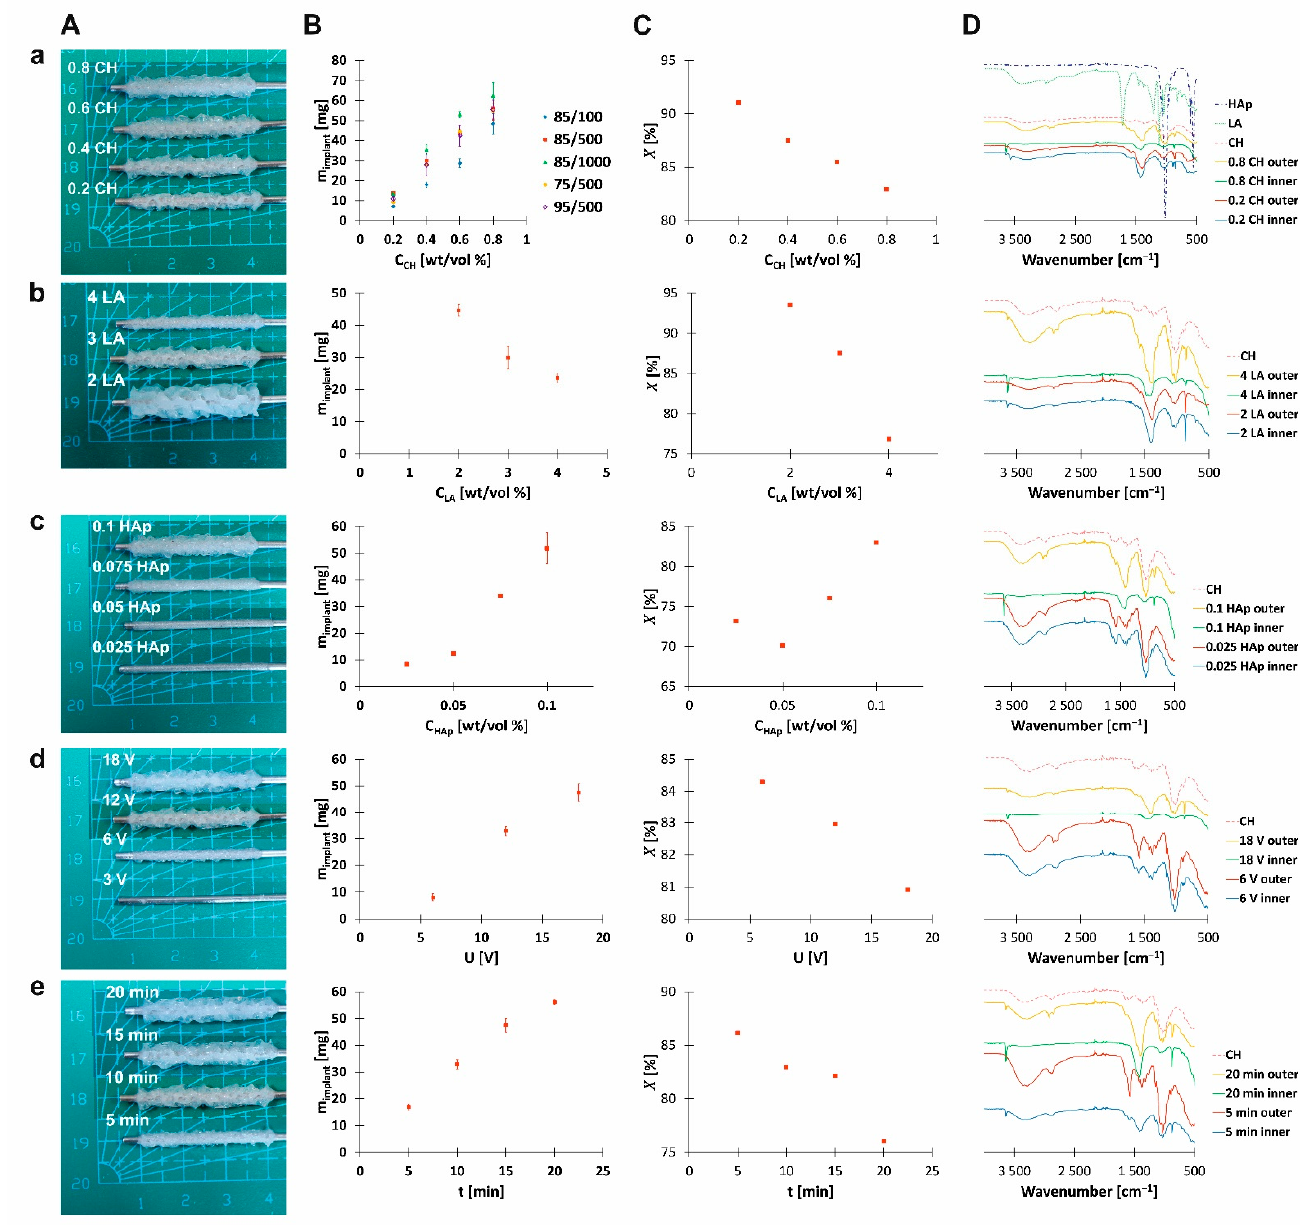
Figure 1. The influence of ( a ) chitosan concentration, ( b ) lactic acid concentration, ( c ) hydroxyapatite concentration, ( d ) voltage, and ( e ) time on ( A ) characteristics, ( B ) dry mass, ( C ) water content, and ( D ) Fourier-transform infrared (FTIR) spectra of tubular-shaped chitosan–hydroxyapatite deposits. The solution concentrations are listed in Table 2.